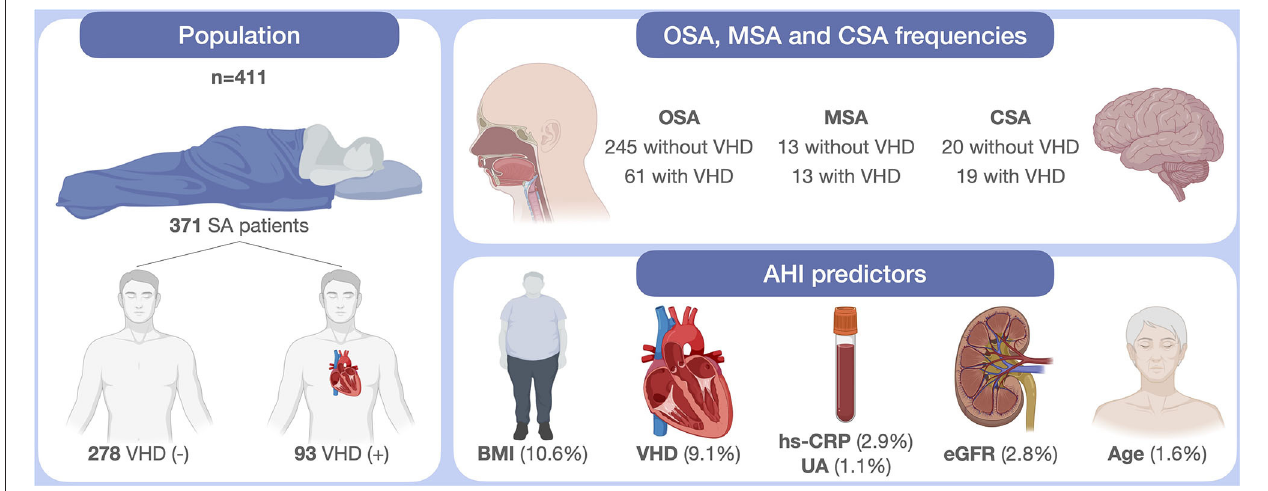
FIGURE 2 | Schematic illustration of study findings. SA, sleep apnea; VHD, valvular heart disease; OSA, obstructive sleep apnea; MSA, mixed sleep apnea; CSA, central sleep apnea; AHI, apnea hypopnea index; BMI, body mass index; hs-CRP, high-sensitivity C-reactive protein; UA, uric acid; eGFR, estimated Glomerular Filtration Rate. This original figure was created by the authors using